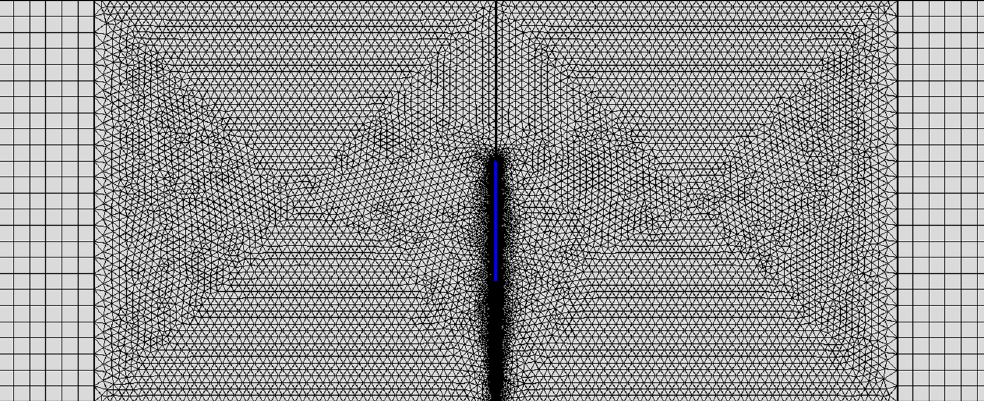
Figure 4. Discretization of the scattering region including its close vicinity; the region where the PET approach was adopted is marked by blue color.